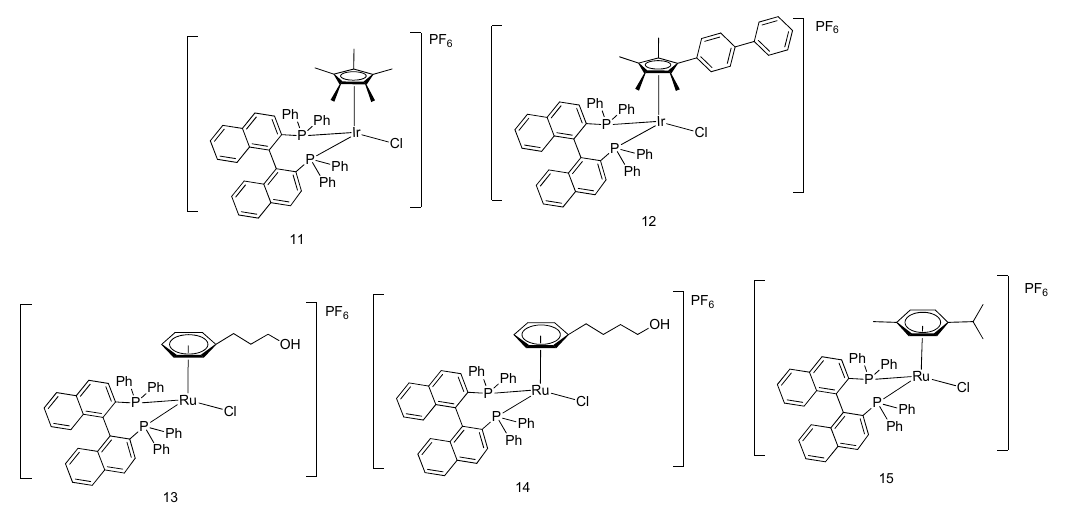
Figure 5 . Organometallic half-sandwich iridium(III) and ruthenium compounds with P^P-chelating ligands.